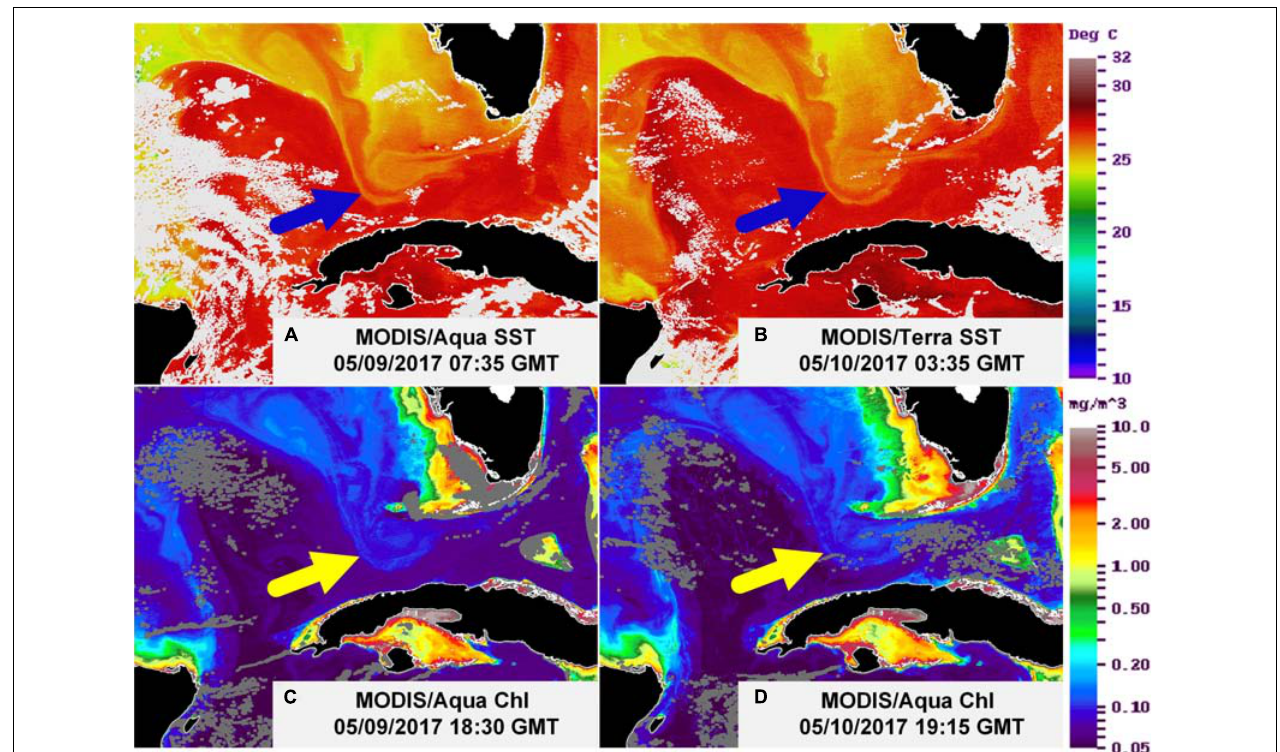
FIGURE 4 | MODIS SST (A,B) and Chl (C,D) imagery on May 9 and 10, 2017 showing a CE off the DT, which is annotated with blue and yellow arrows. The images cover a region of 20–27 ◦ N and 88–79 ◦ W. The white color in the SST imagery and the gray color in the Chl imagery indicate no